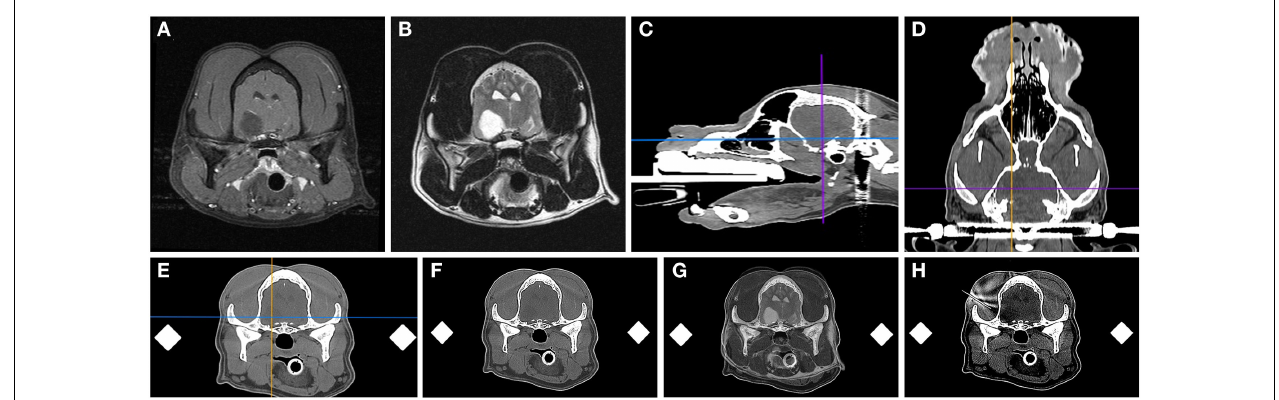
immobilized in the headframe, and CT images obtained for stereotactic planning (C–F) , imported into image analysis software (C–F) and co-registered with the prior diagnostic MR (G) . The planned trajectory is then simulated and verified using a needle blank (H) and the final stereotactic coordinates